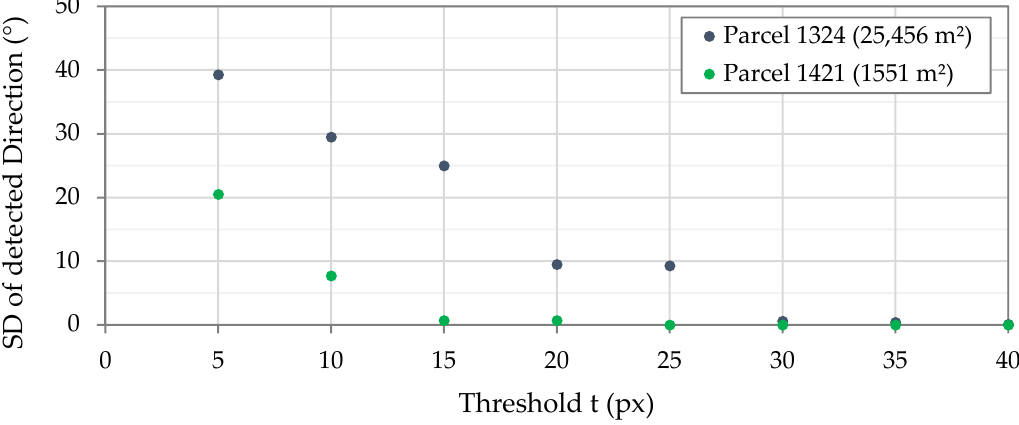
Figure 15. SD for orientation of detected lines depending on Length Threshold t for one small (green, 1421) and one medium–large parcel (blue, 1324); data source: [40,41].